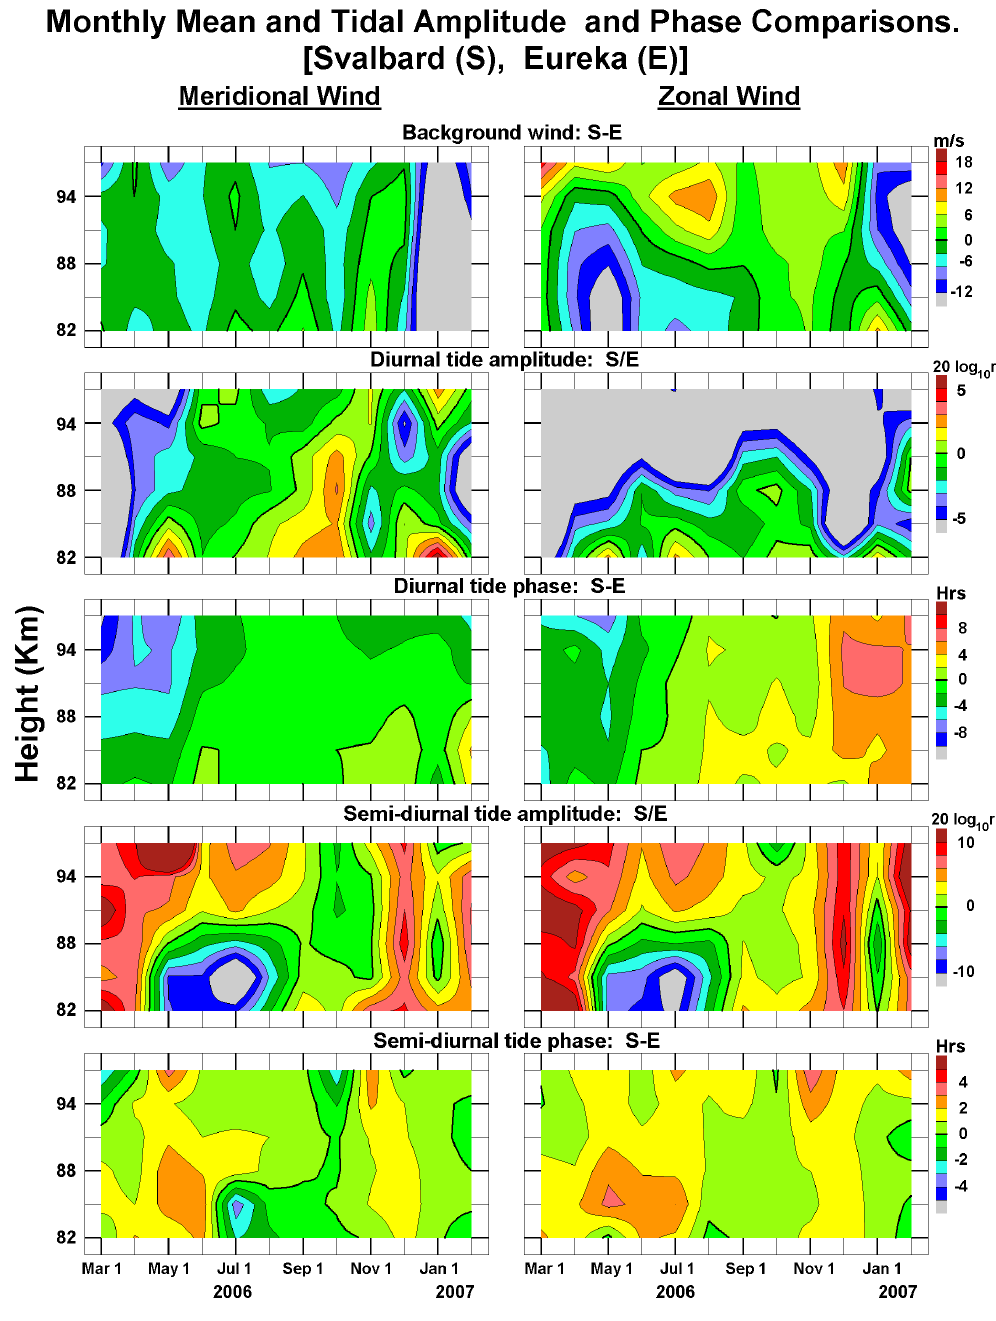
Fig. 8. Comparisons of the two Arctic radar monthly mean winds (differences in m/s), tidal amplitudes (expressed as the logarithmic ratio), and phase differences (of the local solar